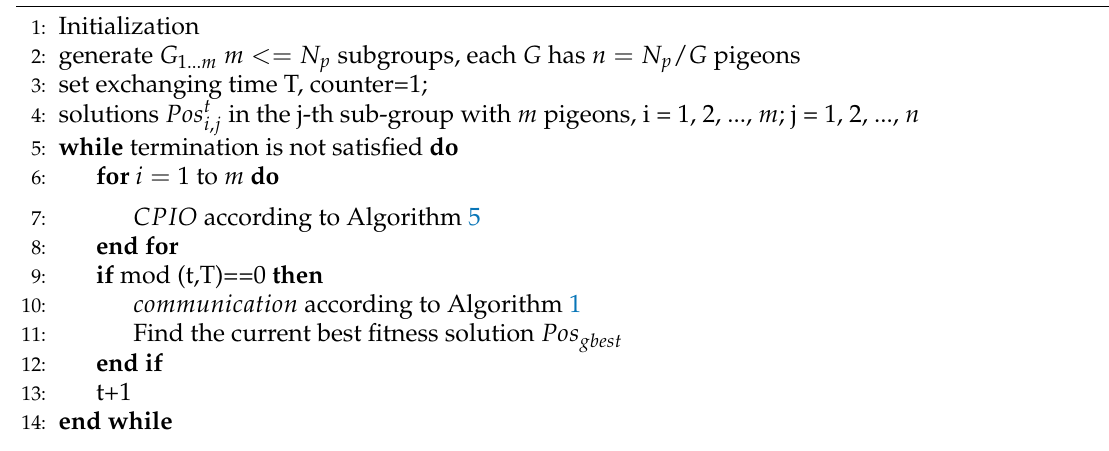
Algorithm 6 Pseudo code for Parallel and Compact Pigeon-Inspired Optimization ( PCPIO